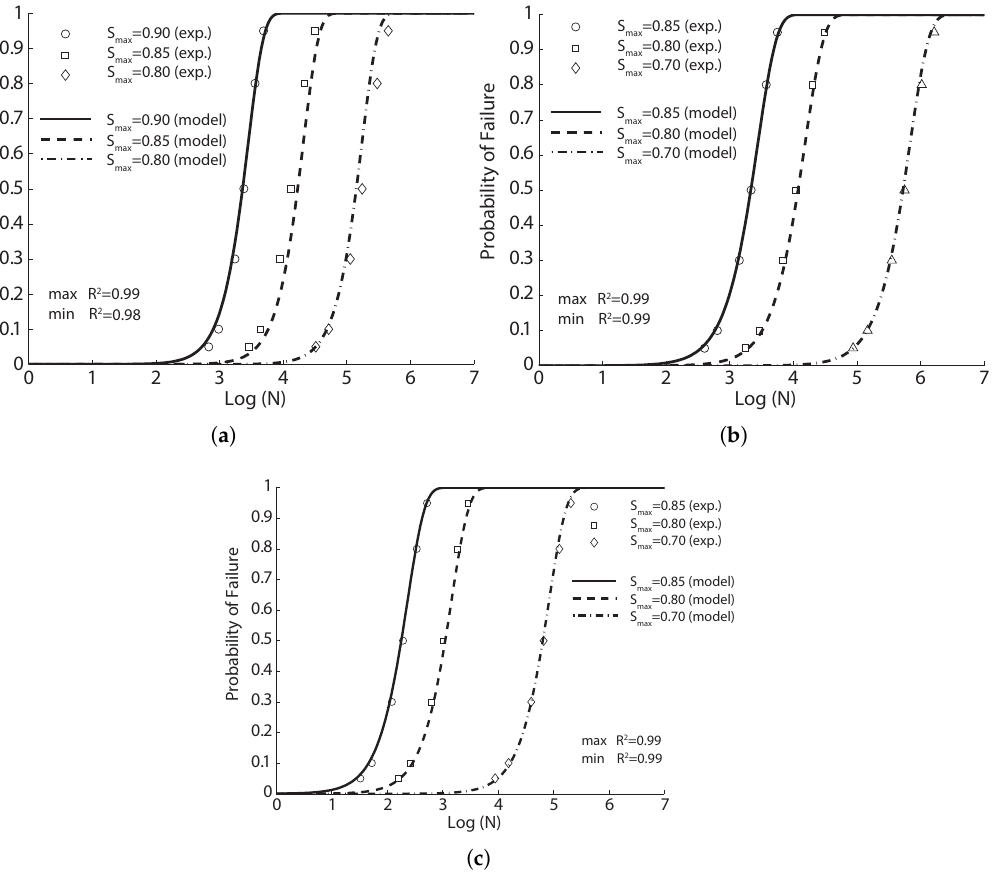
Figure 4. Comparison of the flexural fatigue data of Singh et al. [42] with the fitted probabilistic model Equation (8) for SFRC with volume ratios of ( a ) 1%; ( b ) 1.5% and ( c ) 2%, with 65% of long fibers and 35% of short fibers.